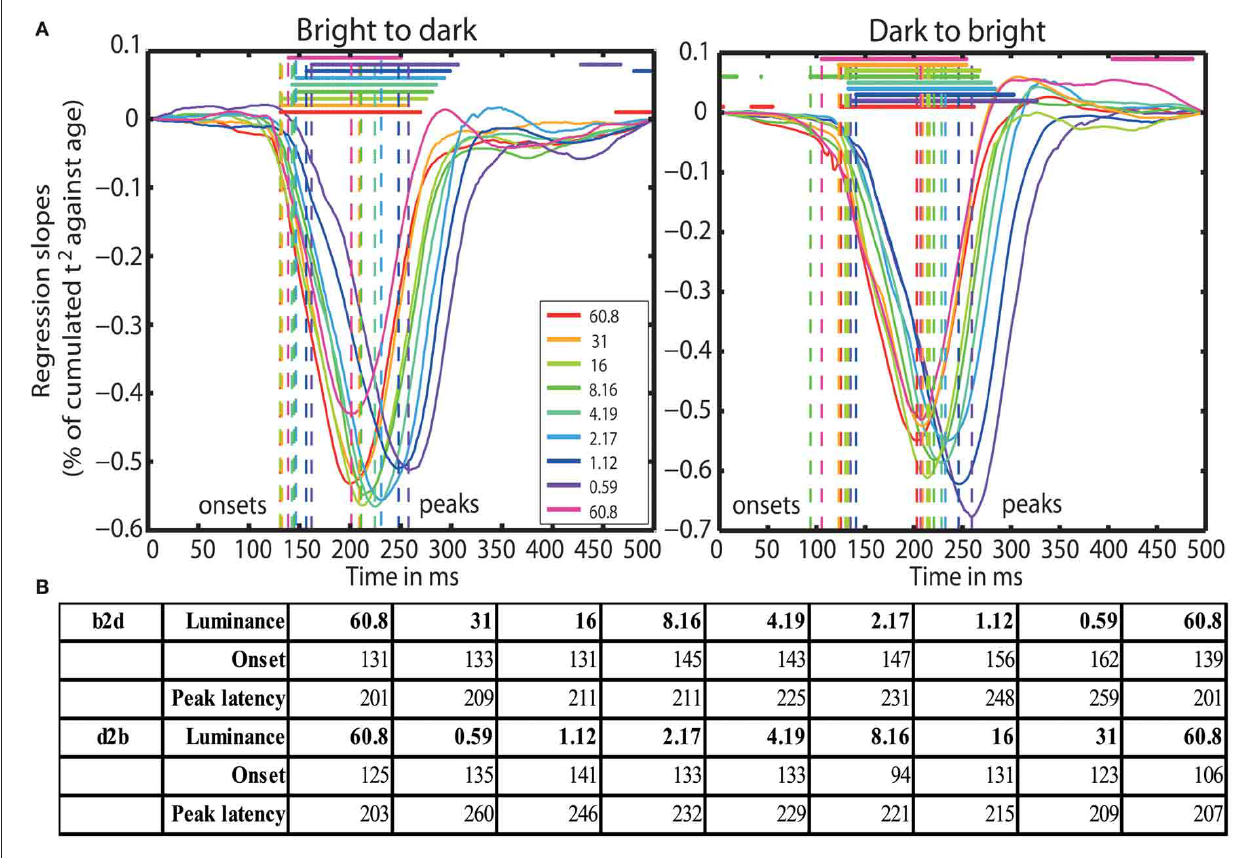
and the peak latencies of significant aging effects. (B) Table of onsets (ms) and peak latencies (ms) of the aging effects on processing speed for all luminance levels (cd/m 2 ) for b2d and d2b experimental